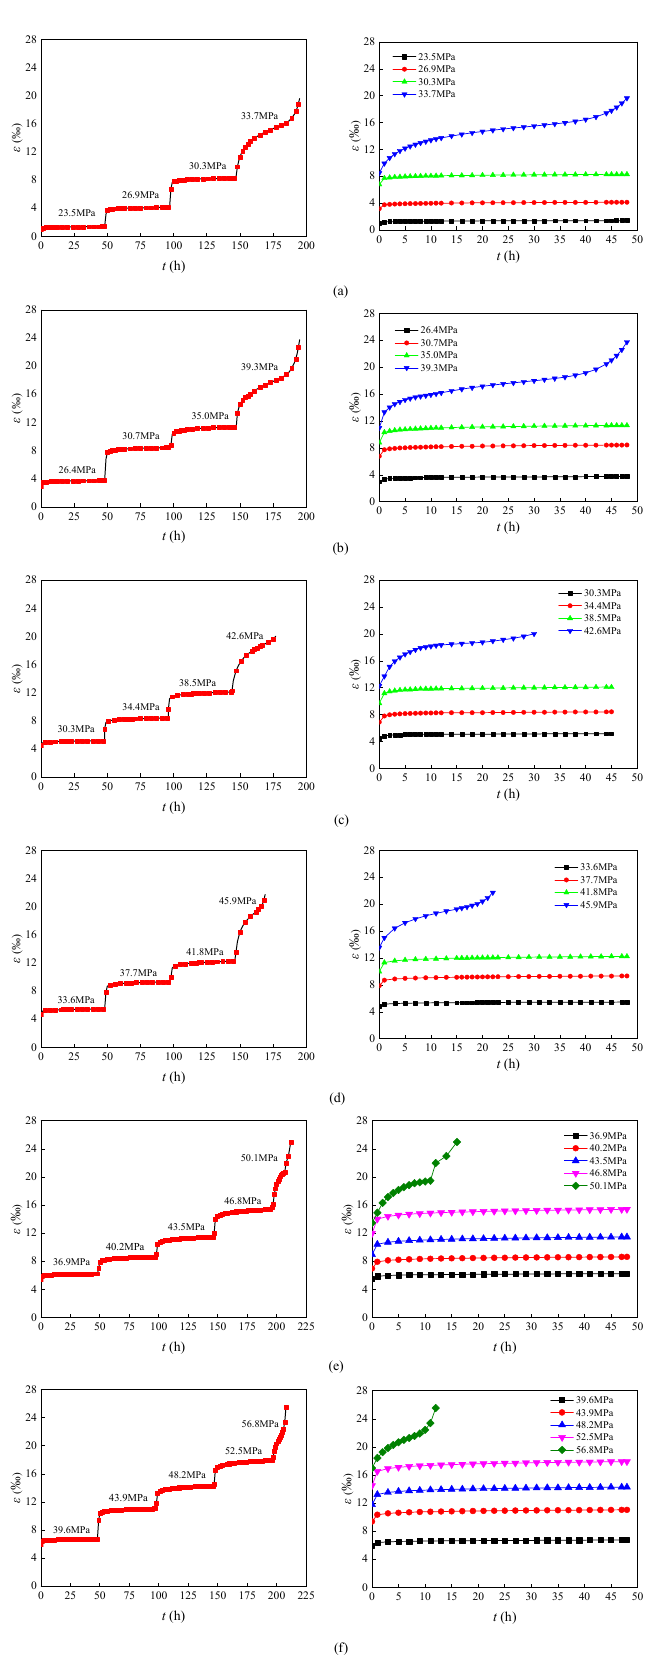
Figure 3. Strain-time curves and strain-time curves for each stage of AS samples under various confining pressures: ( a ) 3 MPa, ( b ) 6 MPa, ( c ) 9 MPa, ( d ) 12 MPa, ( e ) 15 MPa, and ( f ) 18 MPa.